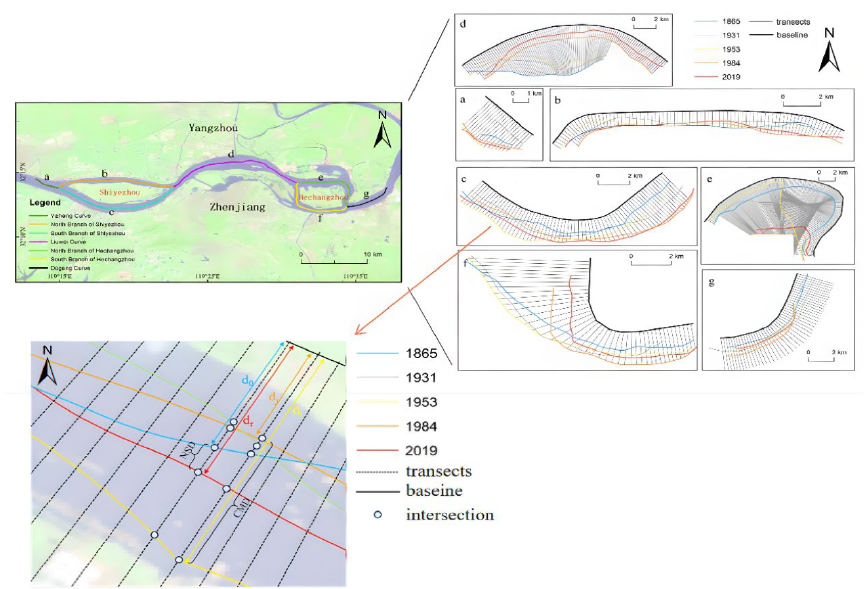
Figure 3. Map of the channel centerline and section position in Zhenyang Reach in different ages and related parameters.